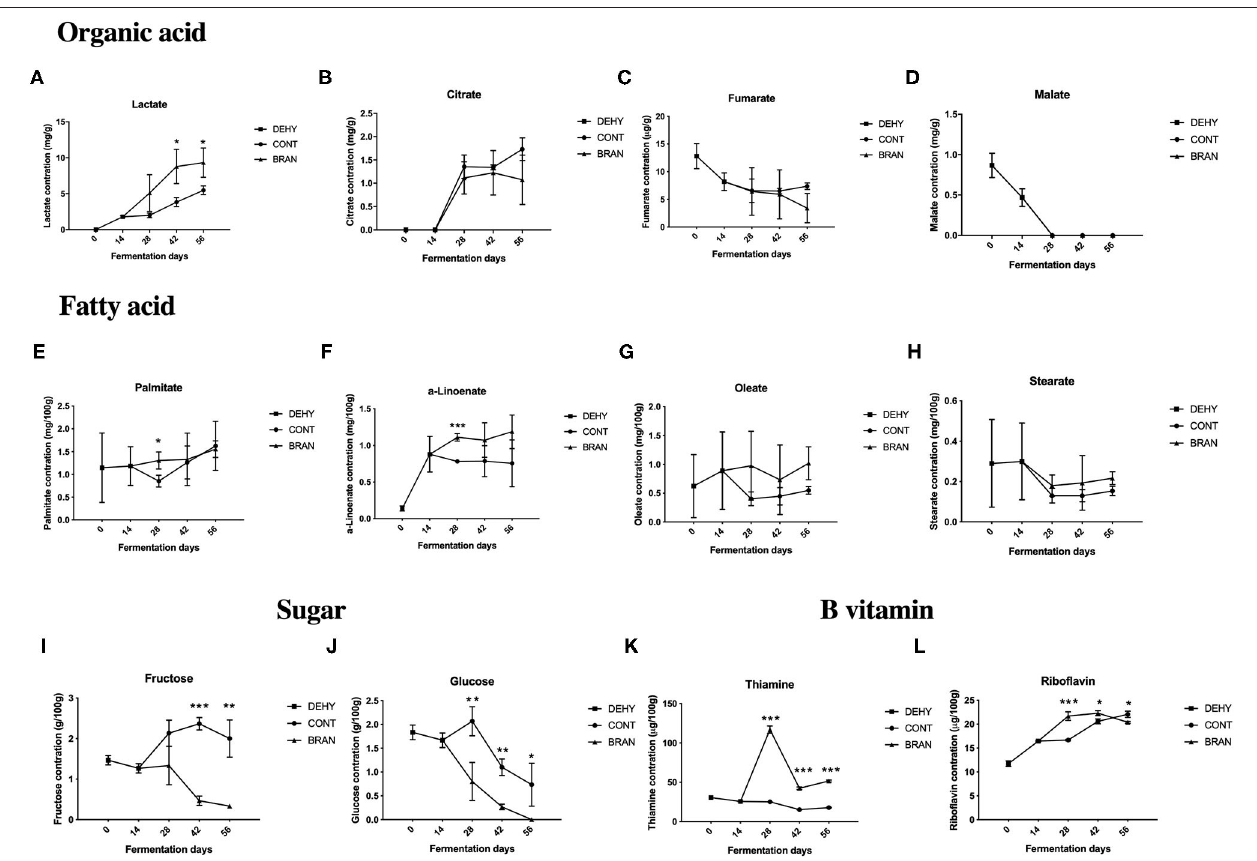
FIGURE 3 | Changes in organic acid (A–D) , fatty acid (E–H) , sugar (I, J) , and B vitamin (K, L) concentrations during the pickling process of radish roots. DEHY: dehydration stage, including days 0 (start of dehydration) and 14, CONT: seasoning stage (days 28, 42, and 56) of the fermented radish without wheat bran, BRAN: seasoning stage (days 28, 42, and 56) of the fermented radish with wheat bran. The data are presented as mean ± SD ( n = 3), and significant differences within each seasoning period between CONT and BRAN are marked as * p < 0.05, ** p < 0.01, *** p < 0.001.